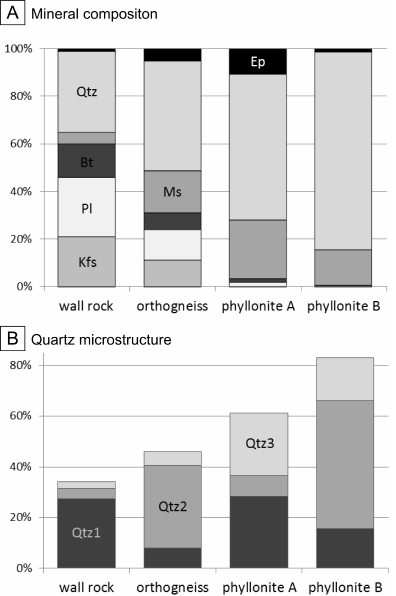
Figure 3. (a) Measured modal mineral compositions of each shear zone domain (Kfs – K-feldspar; Pl – plagioclase; Bt – biotite; Ms – muscovite; Qtz – quartz; Ep – epidote). (b) The estimated modal amounts of different quartz microstructures in each shear zone do- main (see text for